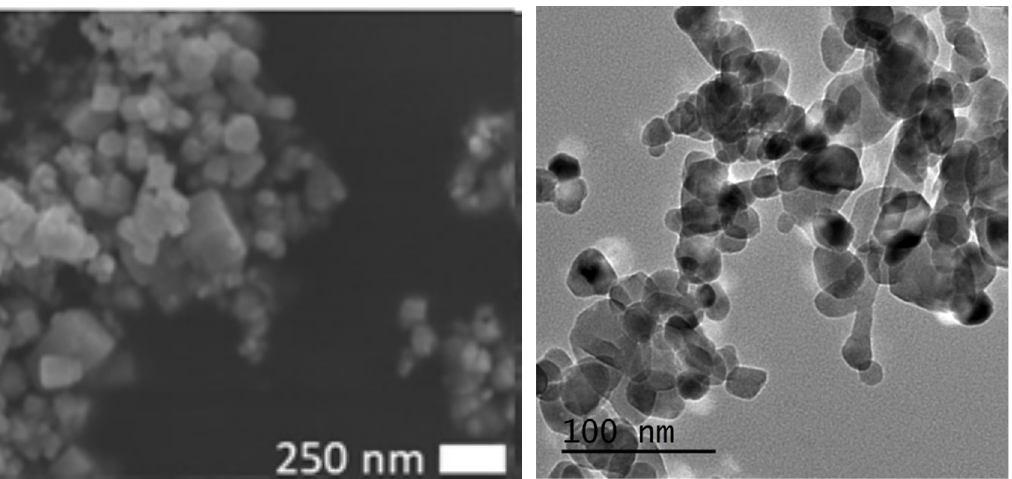
Figure 1. Scanning electron microscopy ( left ) and transmission electron microscopy ( right ) images of methionine coated nano zinc (M-Nano-ZnO; 50,000 × magnification).